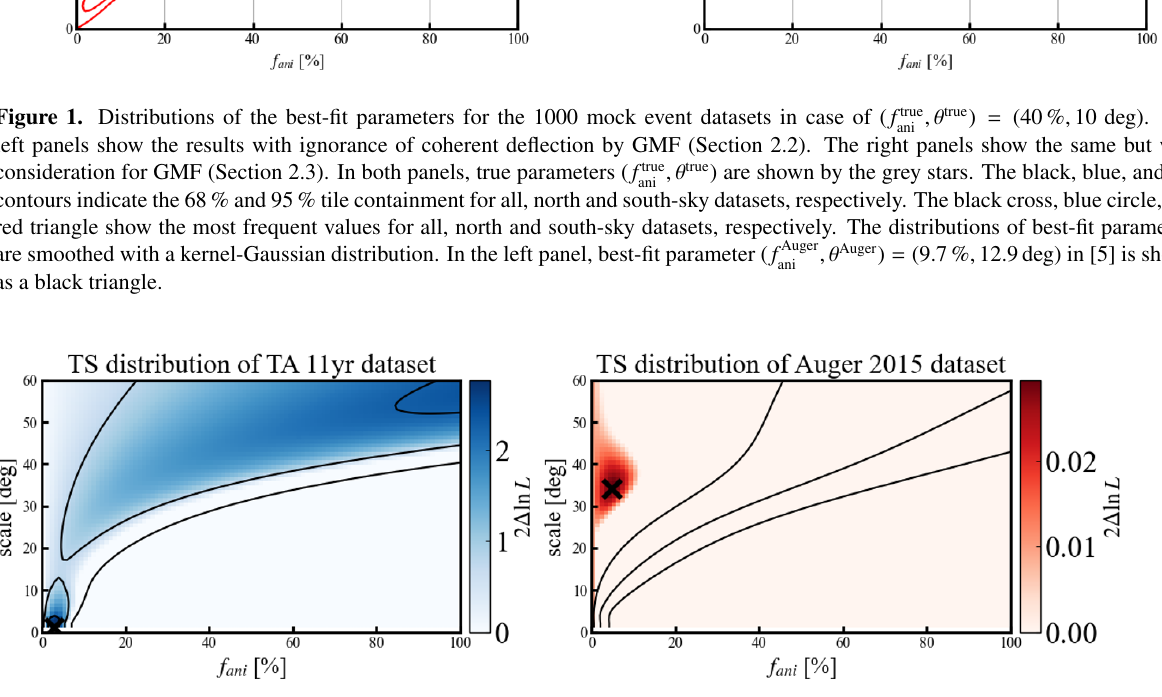
Figure 2. The TS distribution (Section 2.4) with reduction of the GMF bias for the TA-11yr dataset (left) and the Auger 2015 dataset (right). The black cross indicates the best-fit parameter set ( f ani ,θ